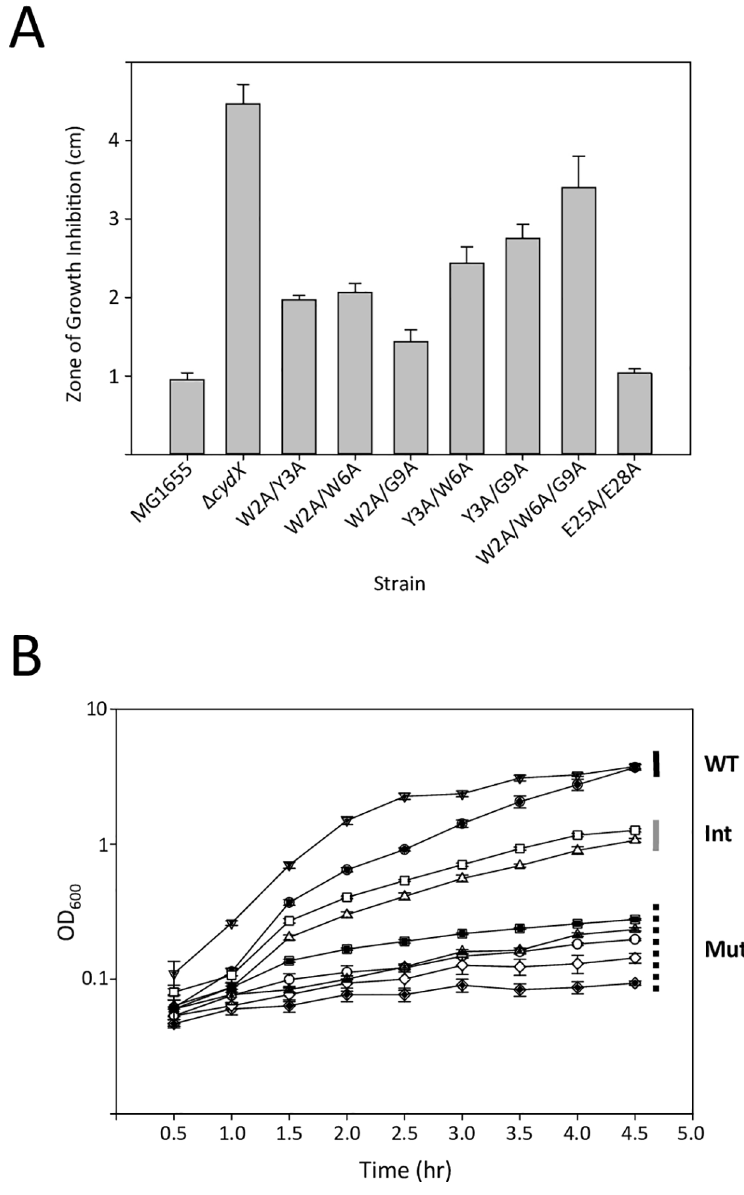
Fig 4. Sensitivity of double and triple amino acid CydX mutants to β -mercaptoethanol. A) Zones of growth inhibition for double and triple mutants. B) Growth of select double and triple cydX mutants in liquid culture containing β -mercaptoethanol. Samples are as follows: wild-type (filled circles), Δ cydX mutant (open circles), cydX +KAN (filled triangle), W2A/G9A mutant (open triangle), Y3A/G9A mutant (filled square), W6A/G9A mutant (open square), W2A/W6A/G9A mutant (closed diamond), Y3A/W6A/G9A mutant (open diamond), Y3A/G9A/L10G mutant (closed triangle). Strains with growth curves similar to wild-type are delineated by a dark line, strains with a growth phenotype similar to the deletion mutant are delineated with a dotted line, and strains with an intermediate growth phenotype are delineated by a grey line. Liquid culture experiments were conducted in Luria Broth containing 20mM β -mercaptoethanol. All experiments were performed in at least triplicate, and the standard error of each experiment is shown.